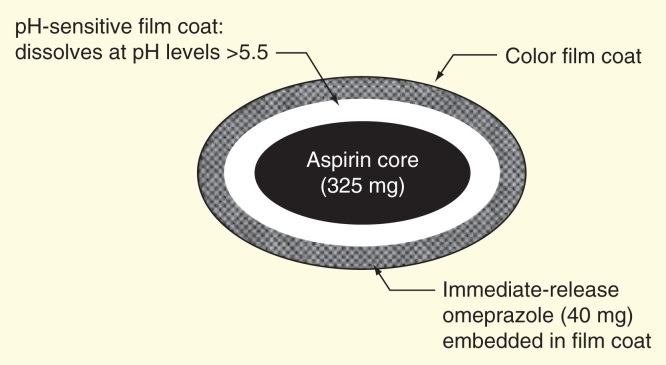

PA32540 coordinated-delivery tablet [28].